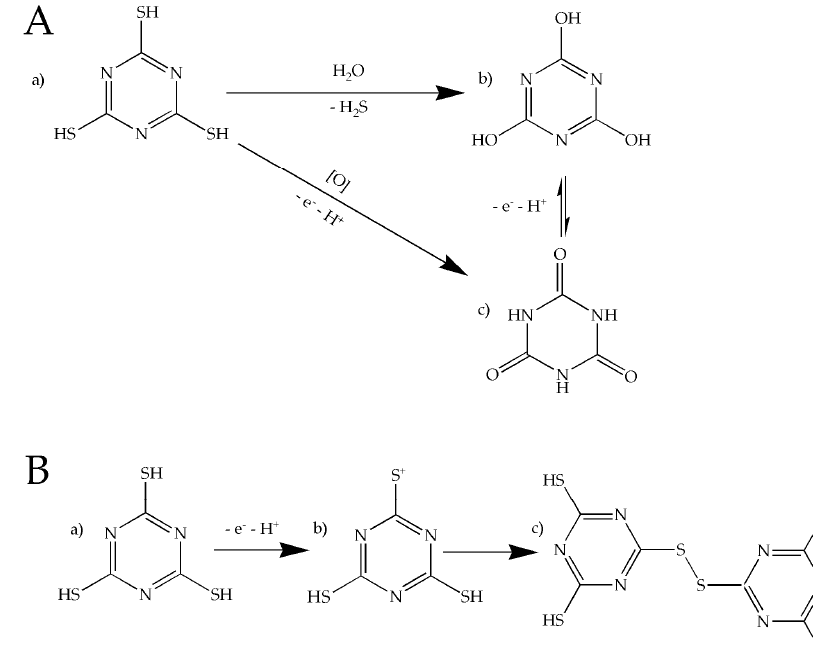
Scheme 2. The proposed electrochemical redox mechanism of ttc. ( A ): two pathways of oxidation of ttc, ( B ): oxidation of ttc followed by the polymerization.